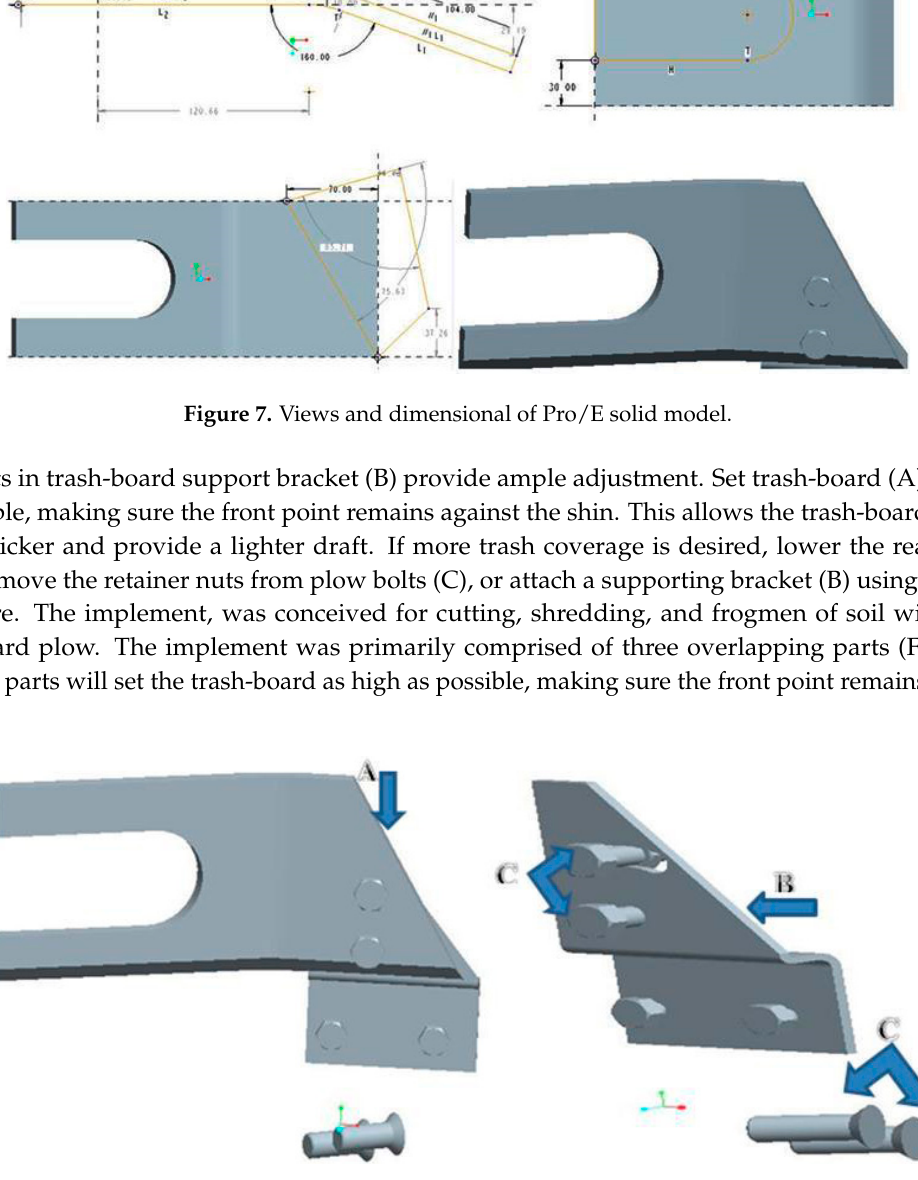
Figure 8. Trash-board parts: ( A ) trash-board; ( B ) support bracket; ( C ) plow bolts.